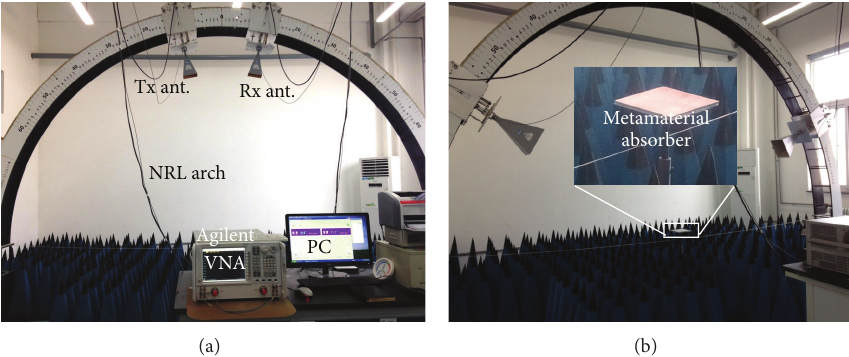
Figure 6: NRL arch used to measure the absorption of the MA at different incident angles. (a) Front and (b) side view of the experimental setup. The insert in (b) shows the zoomed view of the MA under measurement.